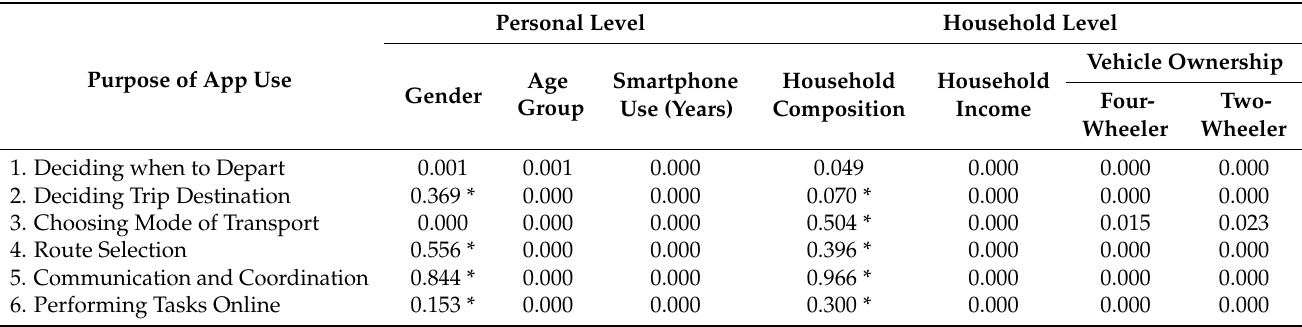
Table 3. Estimated levels of significance ( p -values) for the tested relationship between personal and household level socio-demographic attributes and app usage for trip planning